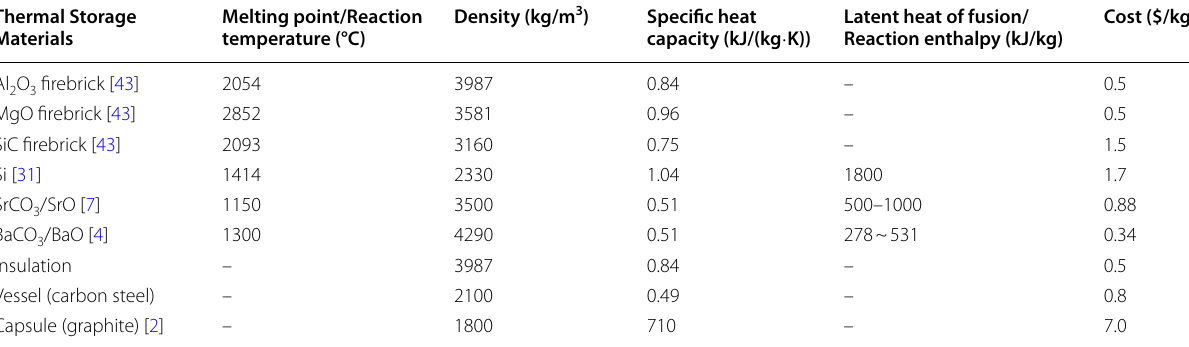
Table 1 TES materials and auxiliary materials discussed in the modeling process Thermal Storage